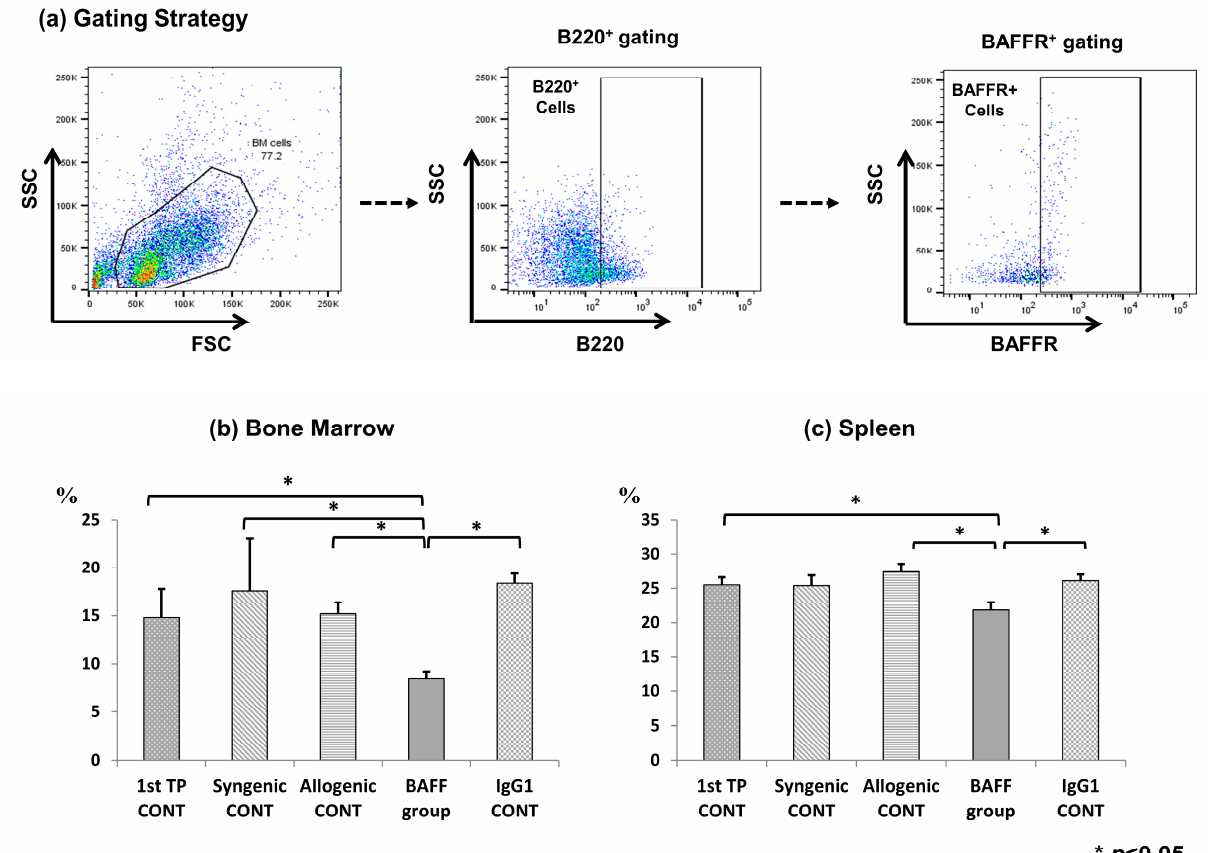
Figure 5. B cell activating factor receptor (BAFFR) expression at week 9 (4 weeks after second transplantation) in the recipient bone marrow and spleen cells analyzed using flow cytometry. ( a ) Gating strategy, ( b ) CD45R(B220) + /CD268(BAFFR) + ) in bone marrow cells, ( c ) BAFFR (CD45R(B220) + /CD268(BAFFR) + ) in spleen cells. Error bars represent 2 standard errors (SE).